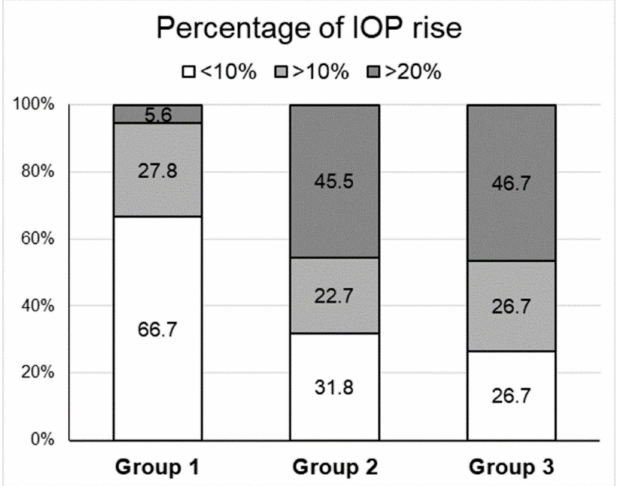
Figure 3. Percentage of patients with increased intraocular pressure (IOP) after treatment in each group. Group 1, autologous serum eyedrops (ASEs) for 2 months without discontinuing glaucoma eyedrops ( n = 18); Group 2, ASEs for 2 months and discontinuing glaucoma eyedrops for the first month ( n = 22); Group 3, non-preservative artificial tears for 2 months and discontinuing glaucoma eyedrops for the first month ( n =